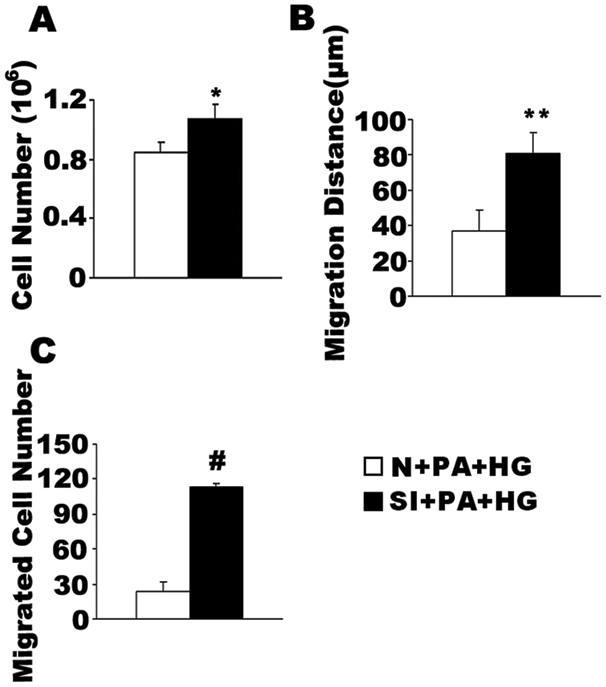
Suppression of PGC-1α abolishes the inhibitory effect of palmitic acid on high glucose-induced VSMC growth and movement.VSMCs were transfected with siRNA (SI) or the negative control (N), then left stimulated with 15 mM gluoose (HG) in the presence of 0.4 mM palmitic acid (PA) for 48 h. Cell growth was determined by counting the number of cells (A). Migration distance was determined by a standard wound healing assay (B) and by transwell analysis (C). The bars represent means±S.E.M (n = 6). *P<0.05, **P<0.01, #P<0.001 compared with the N+PA+HG group.